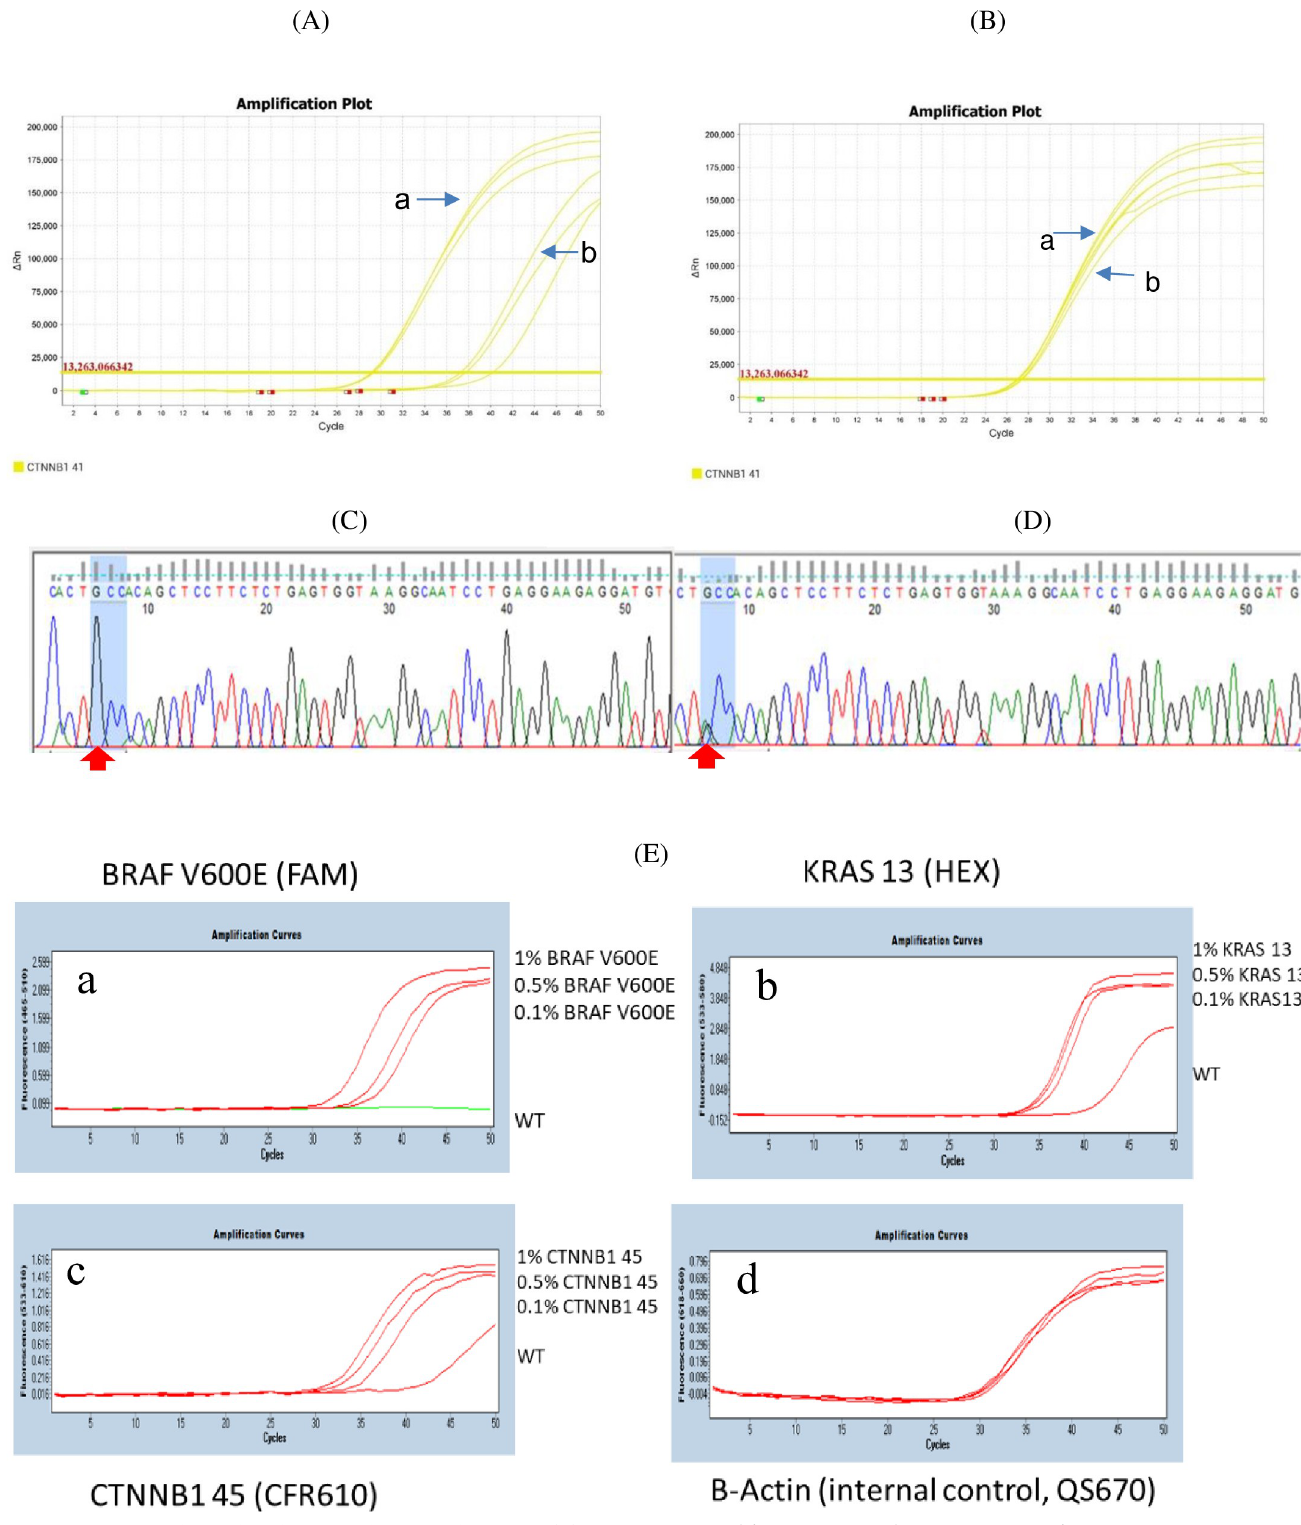
Fig 2. Comparison of XNA-based qPCR and qPCR without XNA. (A). CTNNB1 T41 amplification curves with XNA. a: 5% VAF of CTNNB1 T41 mutant, CT = 29.1 (ACTB, CT = 30.7, not shown here due to the use of Cy5 channel), b: CTNNB1 T41 wildtype, CT = 38.3 (ACTB, CT = 30). This indicates that XNA-based qPCR has a Δ Ct of ~9 for mutant to wildtype. (B). CTNNB1 T41 amplification curves without XNA. a, 5% VAF of CTNNB1 T41 mutant, CT = 26.9 (ACTB,